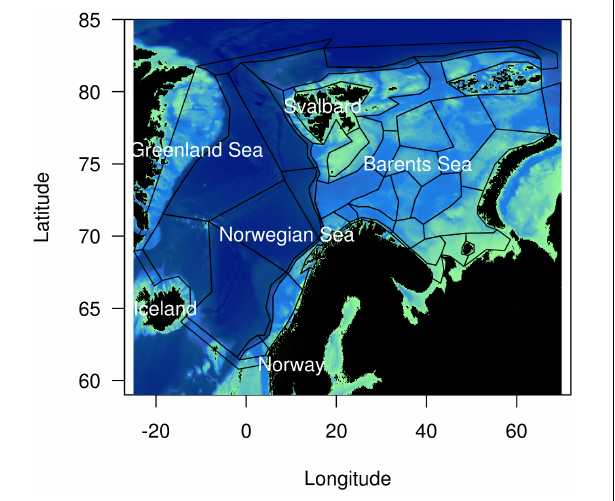
FIGURE 1 | Topography of the Norwegian, Barents and Greenland Seas, and polygons in the NoBa model domain. Dark colors indicate deep areas.